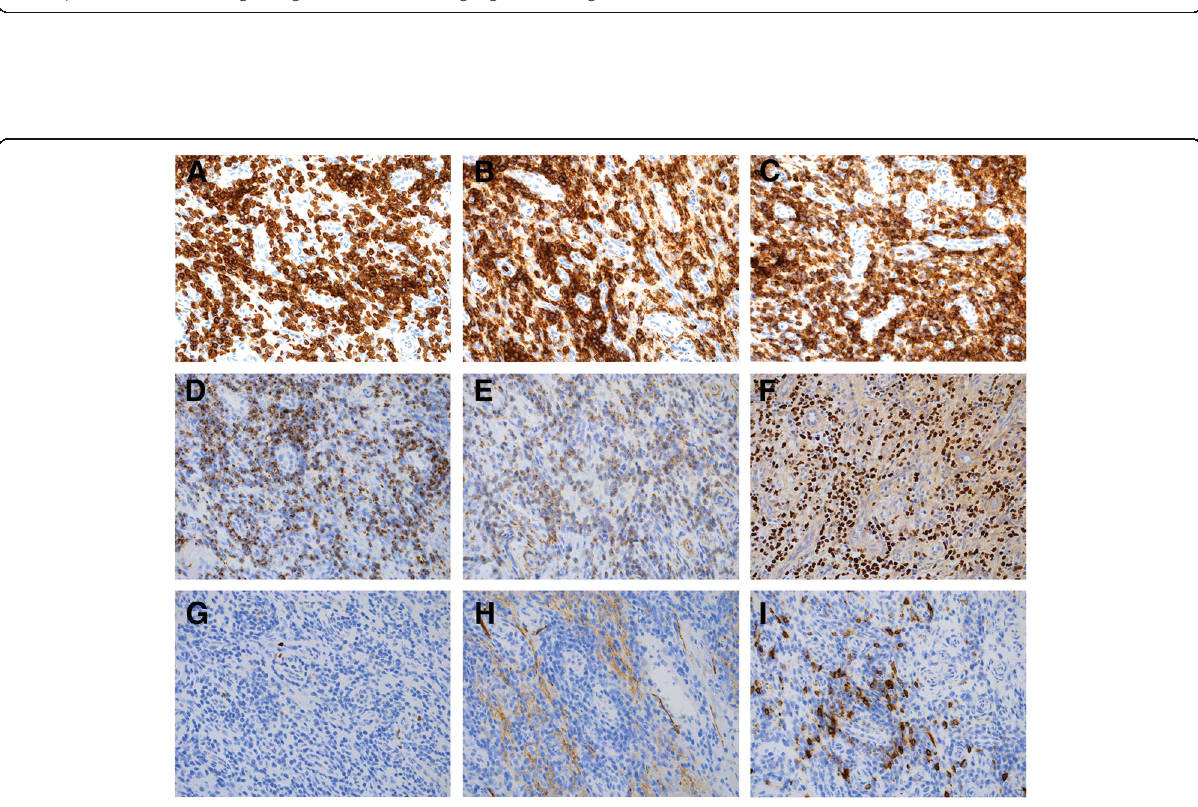
Fig. 2 Immunohistochemical findings of the nasal biopsy. a CD3 (200x) b CD2 (200x) c CD5 (200x) d granzyme B (200x) e perforin (200x) f EBER g Ki-67 h CD56 (200x) i CD20